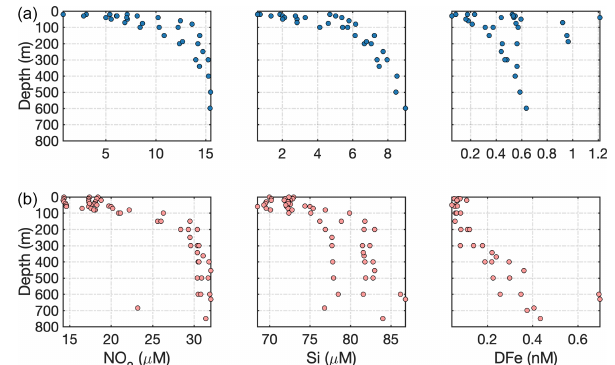
Figure 6. Contrasting nutrient properties of water on the (a) south- east Greenland shelf (data from Achterberg et al., 2018) with (b) the Ross Sea shelf (data from Marsay et al., 2017). Note the different scales used on the x